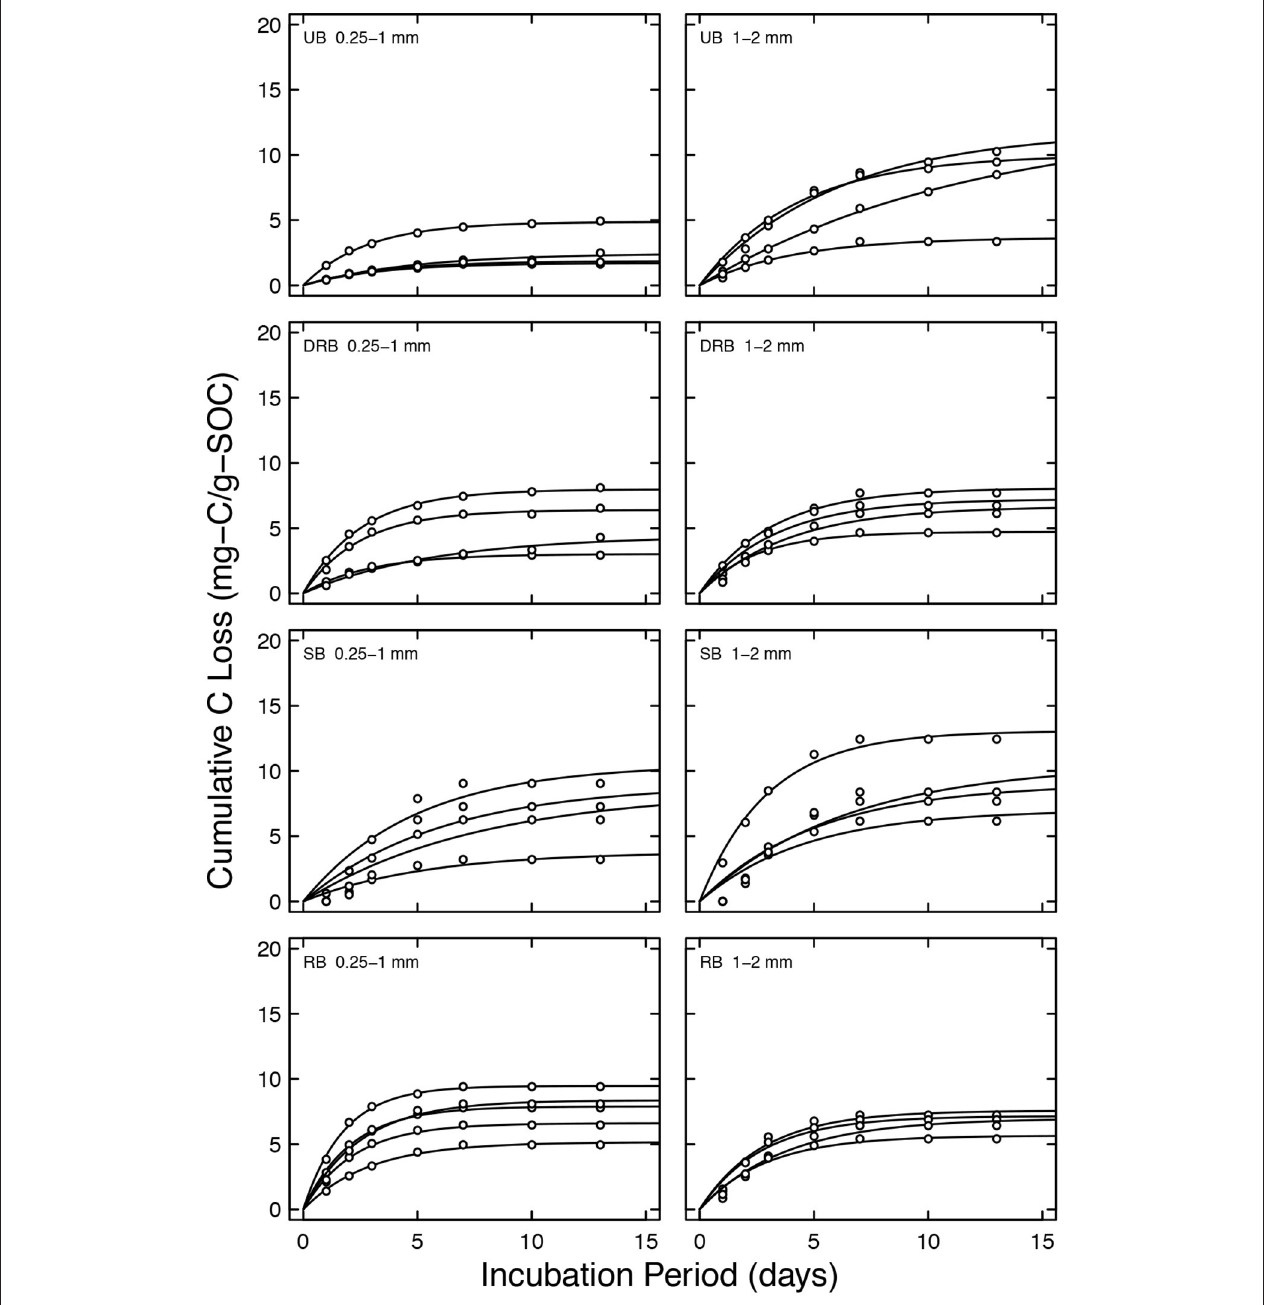
FIGURE 5 | Cumulative CO 2 -C loss in µ gC g soil − 1 for shrubland soil aggregates of two size classes: 0.25–1 and 1–2mm. Solid lines are model fits.